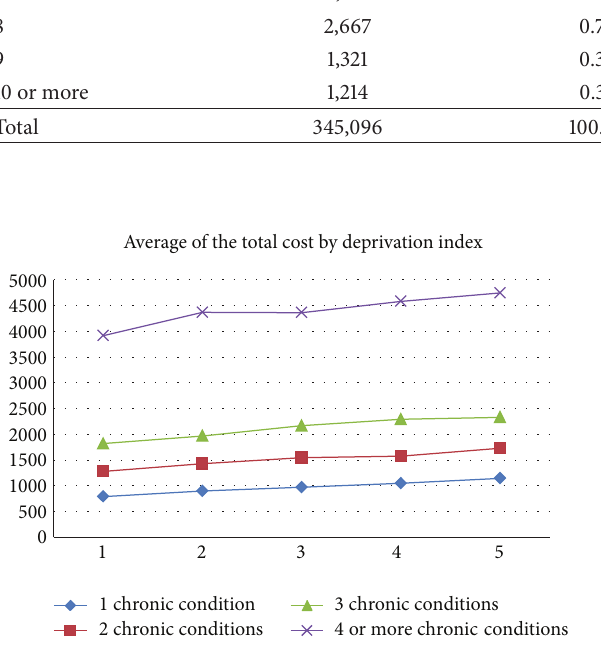
Figure 3: Observed average healthcare cost in women with osteo- porosis by number of chronic conditions and deprivation